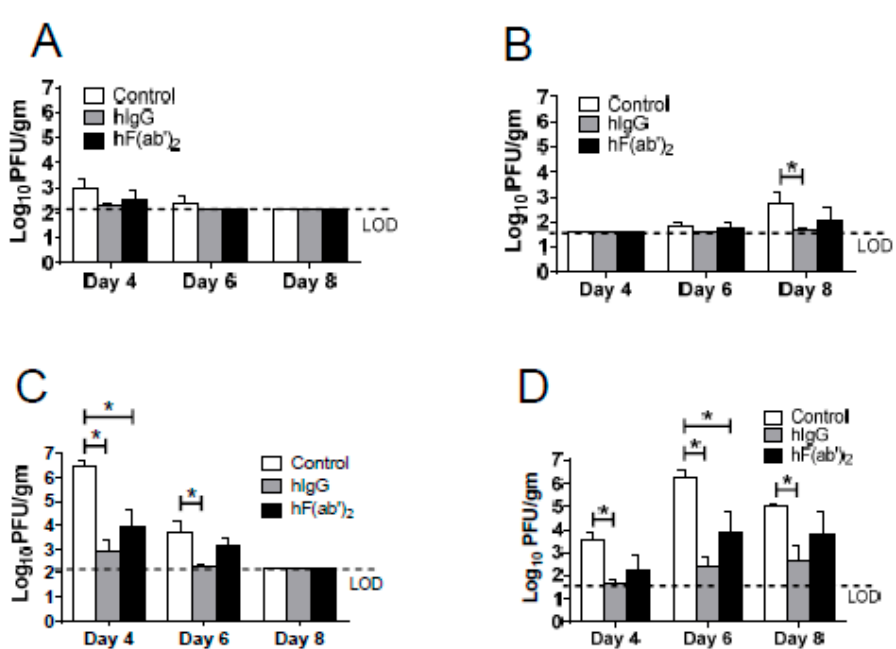
Figure 5. Immune purified IgG and F(ab ′ ) 2 transfer reduced the WNV load in the mice. Eight to twelve ‐ week ‐ old WT ( A , B ) and Mavs − / − mice; ( C , D ) were infected with 100 PFU WNV in the footpad (s.c.), and 500 μ g of the purified horse immune IgG (hIgG) or the purified horse immune F(ab ′ ) 2 (hF(ab ′ ) 2 ) was transferred (i.p.) one day before and one day after infection. To obtain the virus titers, the spleens ( A , C ) and brains ( B , D ) were homogenized at the indicated time points and titered using Vero cells. The titers are expressed as PFU/g tissue. n = 3–4 mice/group/time point. * p < 0.05. The mice that received normal horse IgG were used as the controls.